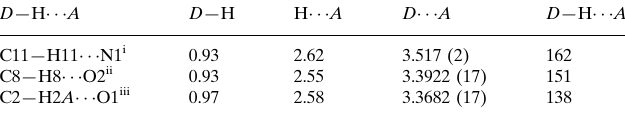
Hydrogen-bond geometry (A˚ , (cid:2)